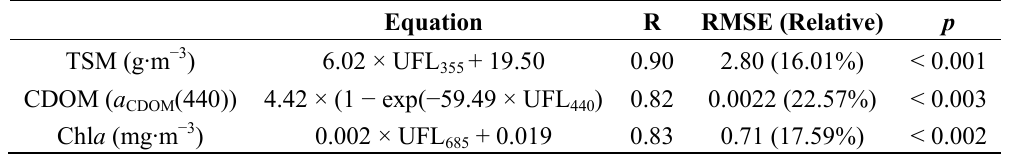
Table 5. Results of Lake Balaton UFL field measurement calibration and validation; model equations, Pearson moment correlation coefficient; root mean square error (absolute and relative) and p-values for TSM, CDOM and chl a